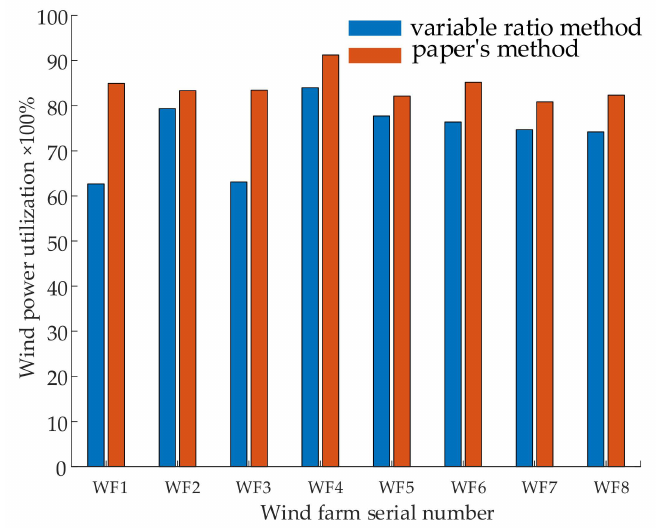
Figure 5. Wind power utilization rate of two wind farms with different methods.